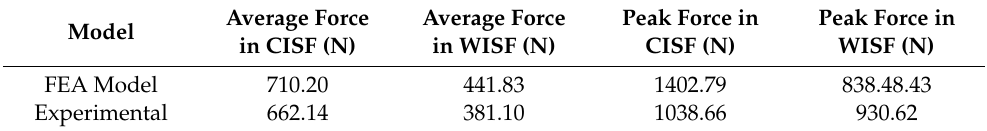
Table 7. Average and peak values of F Y obtained from FEA model and experimentally.